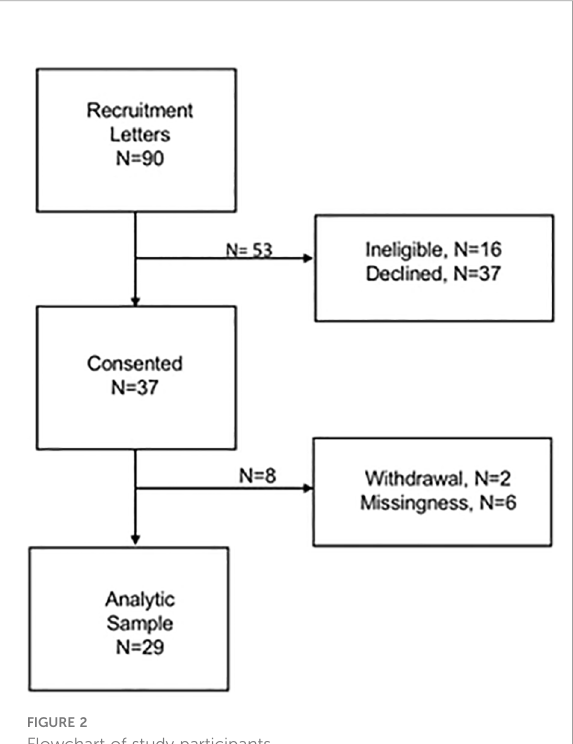
FIGURE 2 Flowchart of study participants